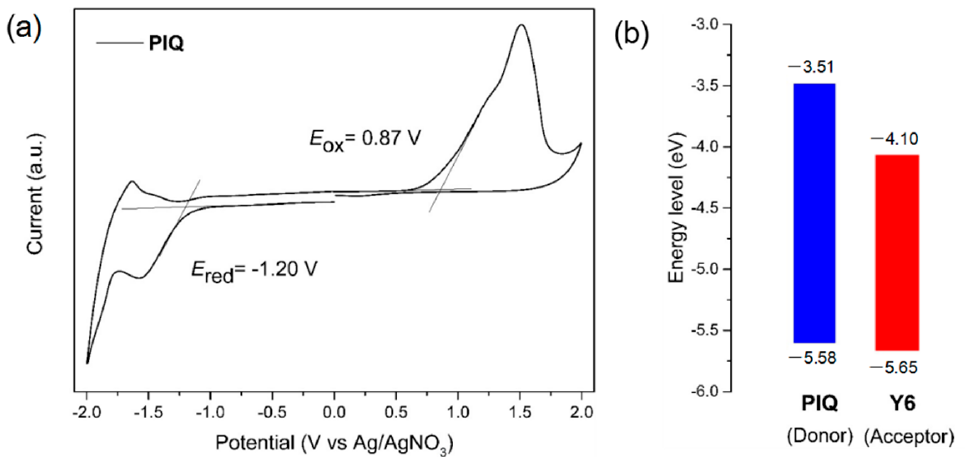
Figure 3. ( a ) Cyclic voltammetry curve of the PIQ thin film; ( b ) energy level diagram of the PIQ donor and Y6 acceptor.